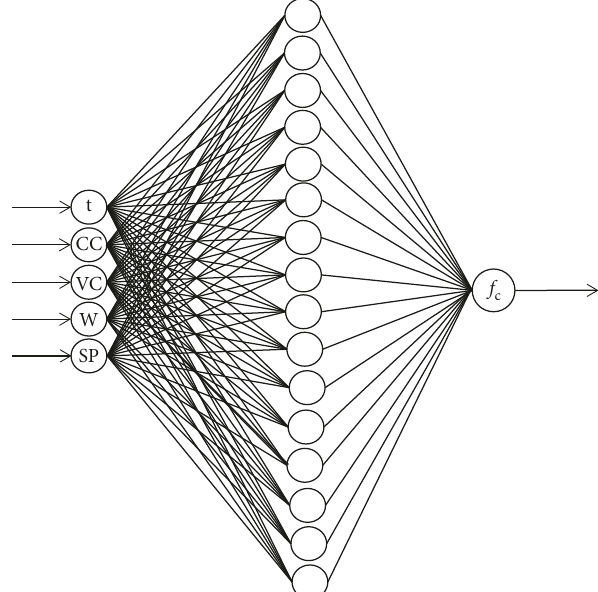
Figure 4: ANN1 model for predicting the compressive strength of VS-based concrete.